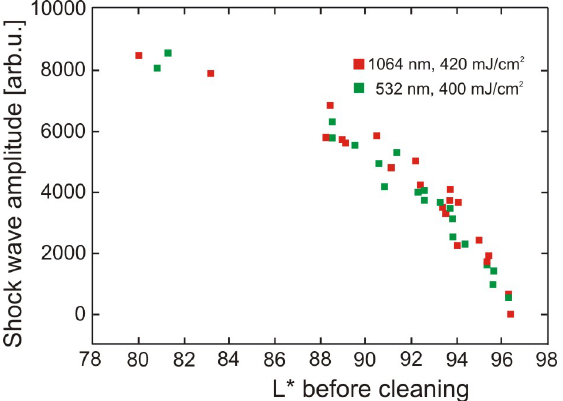
Figure 44. Shockwave amplitude after first laser shot at the conditions as indicated, as a function of density of the deposited soiling. Lower L * denotes higher soiling density.